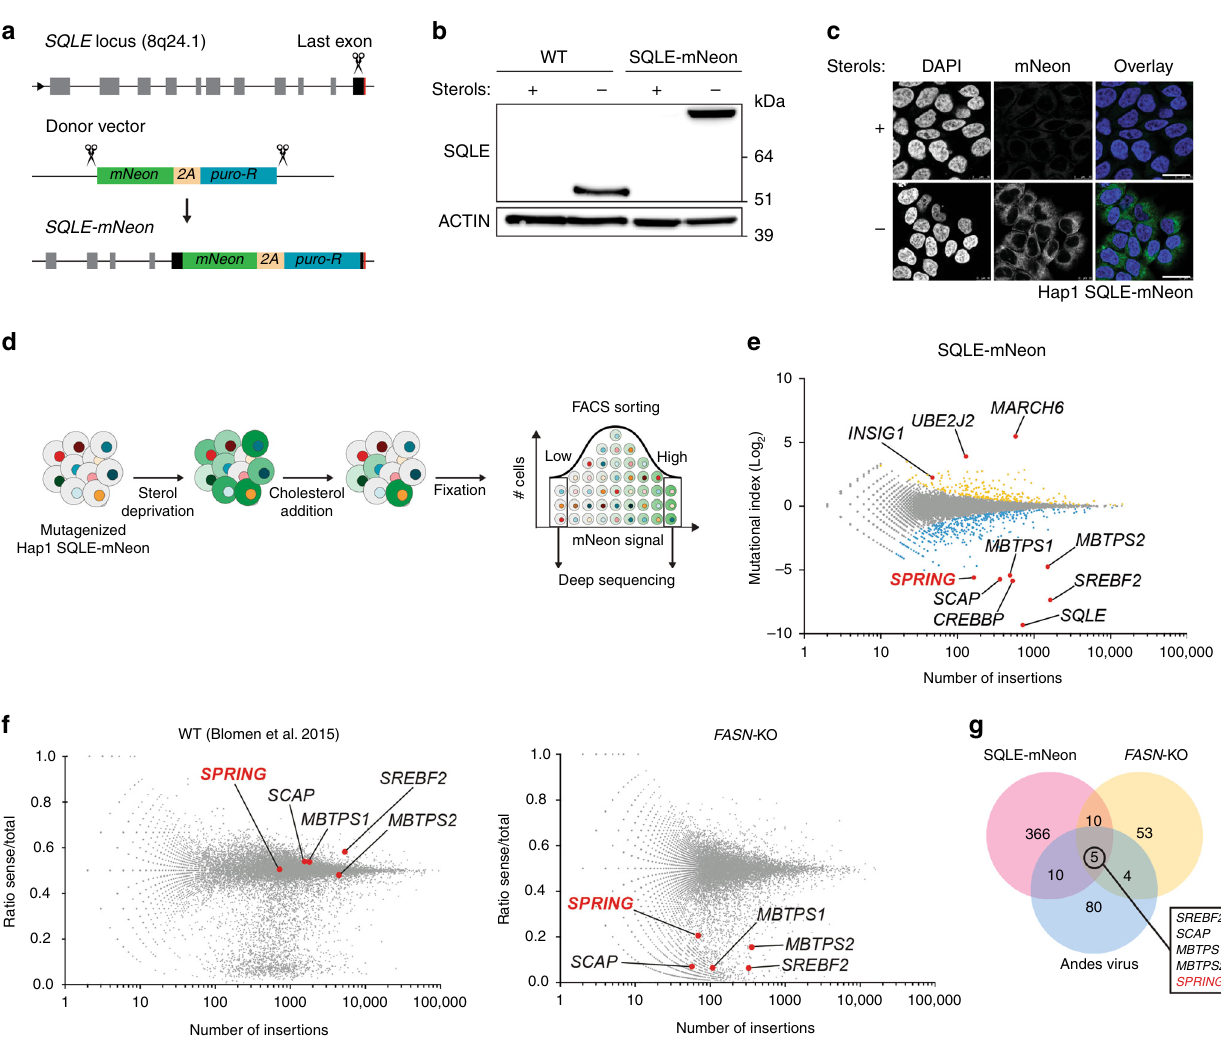
Fig. 1 Haploid mammalian genetic screens identify SPRING as an SREBP regulator. a Schematic illustration of CRISPR/Cas9-mediated targeting of the endogenous SQLE locus for in-frame integration of mNeon-2A-PURO. b Hap1 control and Hap1 SQLE-mNeon cells were cultured in the presence or absence of sterols and total cell lysates were immunoblotted as indicated. c Hap1 SQLE-mNeon cells were grown as in b on coverslips and subsequently fi xed and counterstained with DAPI (nucleus). Cells were imaged and representative images are shown; scale bar, 25 μ m. d Schematic depiction of SQLE- mNeon screen: a library of mutant Hap1 SQLE-mNeon cells was cultured in sterol-depletion medium for 24 h to induce SQLE expression. During the last 6 h β -methyl-cyclodextrin-cholesterol was added to initiate sterol-stimulated degradation of SQLE after which mNeon HIGH and mNeon LOW cells were isolated by FACS. e The log mutational index-scores (see Methods section) were plotted against the number of trapped alleles per gene. Statistically signi fi cant hits ( p < 0.05) in the isolated mNeon HIGH and mNeon LOW cell populations are indicated in yellow and blue, respectively. f Comparison of gene-essentiality screens between control Hap1 cells and Hap1-FASN KO cells. Per gene, the ratio of sense/total orientation gene-trap insertions ( y -axis) and the total number of insertions in a particular gene ( x -axis) are plotted. FASN synthetic lethality screens show that SCAP , SREBF2 , MBTPS1/2 , and SPRING are signi fi cantly depleted in FASN KO cells. g Venn diagram indicating the number of unique and commonly identi fi ed genes in 3 individual SREBP-focused screens. b , c Representative images of three independent experiments are